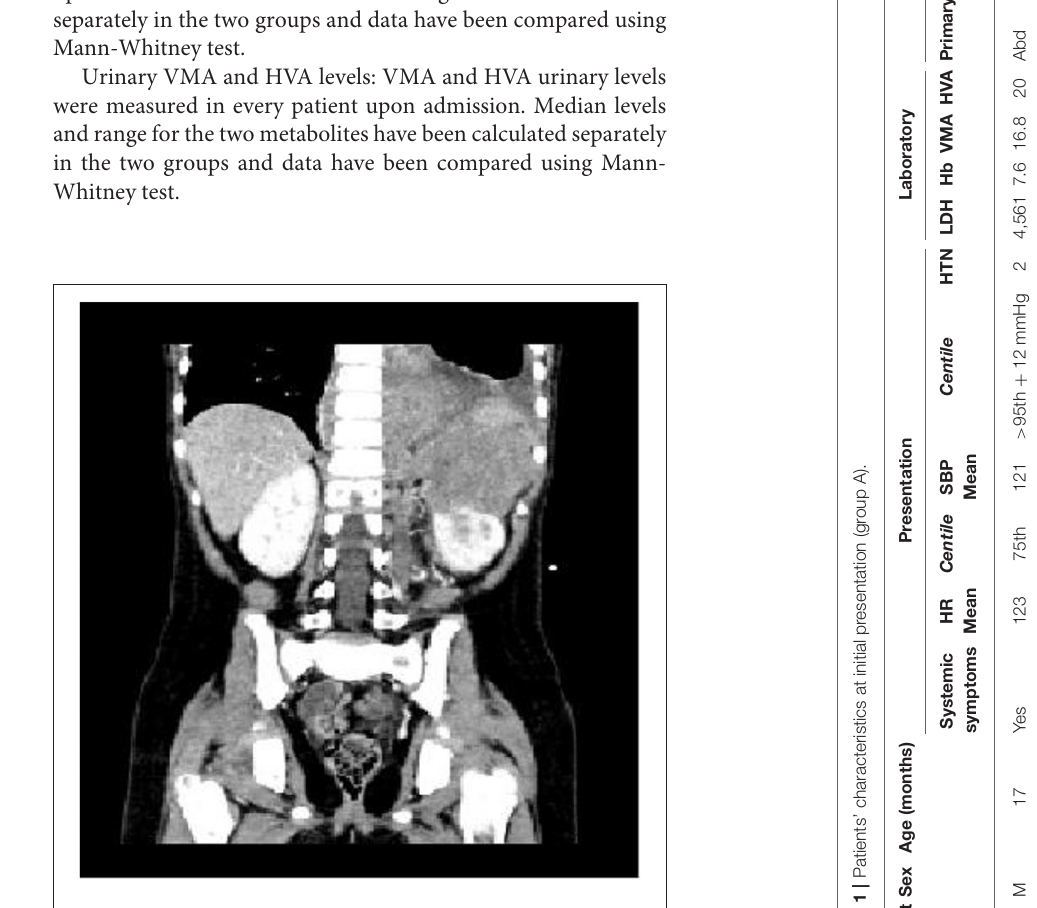
FIGURE 1 | Left retroperitoneal neuroblastoma with posterior mediastinum